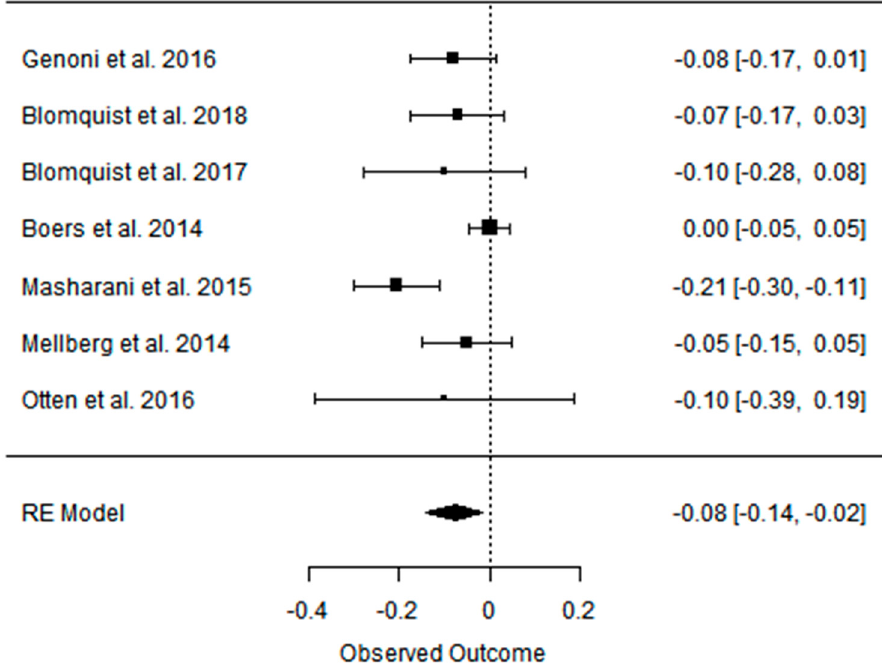
Figure A21. Forest plot of the effect of PD on HDL-C in the short term (weighted mean difference).